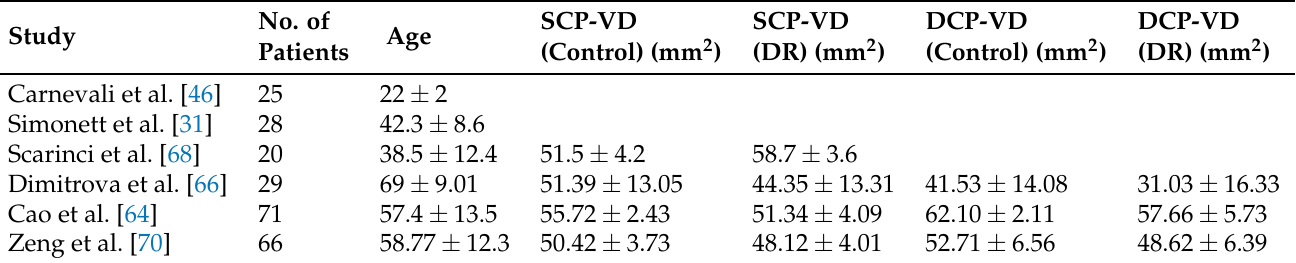
Table 4. The average VD in both normal and early DR